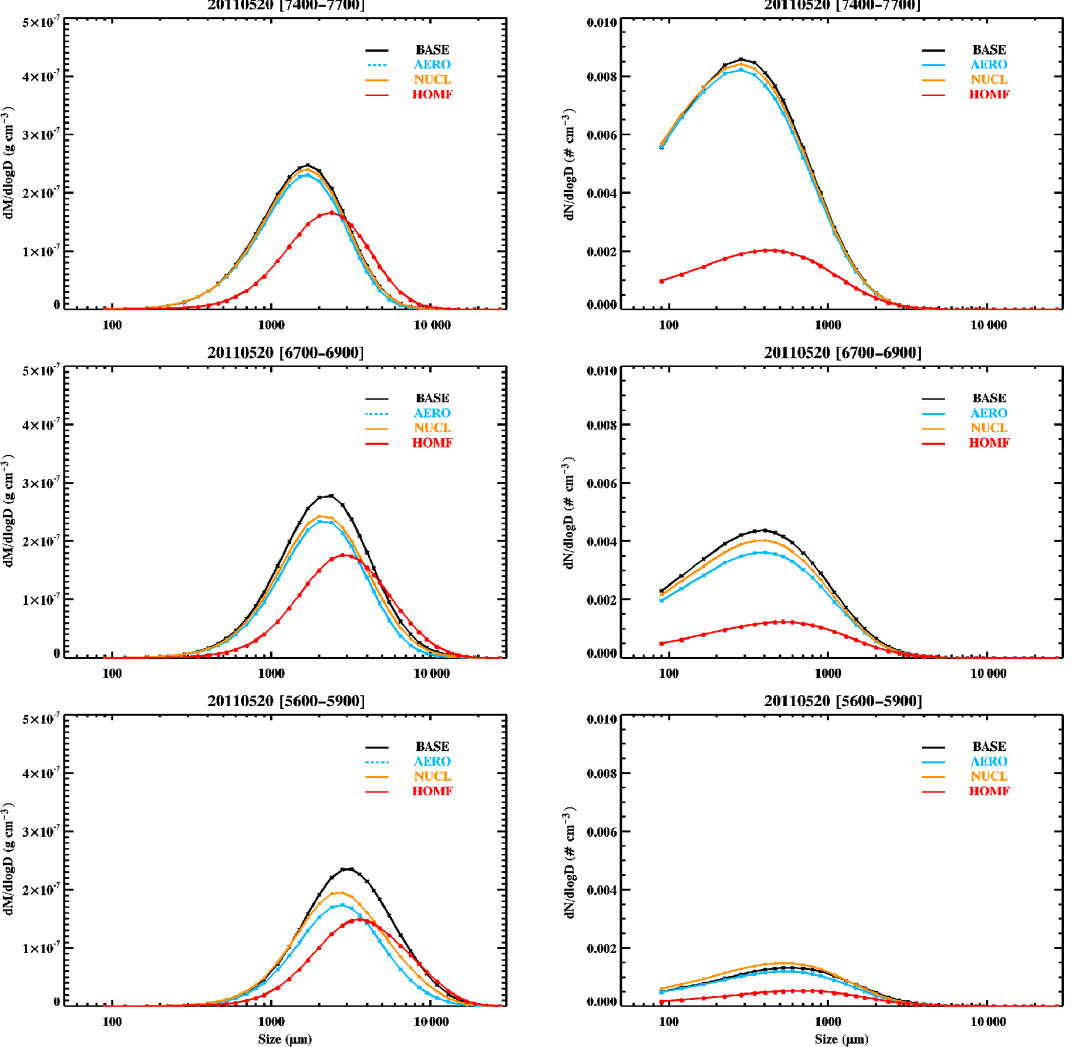
Figure 15. Simulated ice number and mass size distributions averaged over the red-bounded geographic region shown in Fig. 9 at 13:00– 14:00UTC. Each panel shows the results from four simulations as labeled (cf. Table